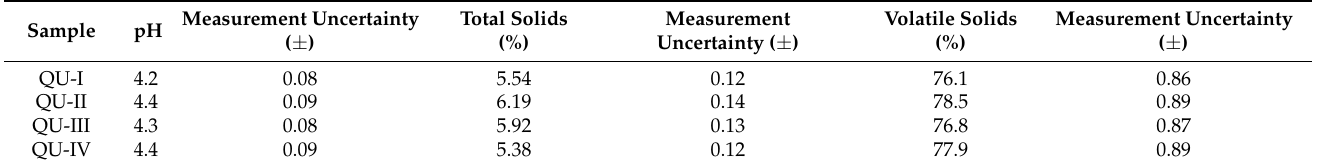
Table 7. Parameters of stillage samples fed to the biogas installation in consecutive quarters.